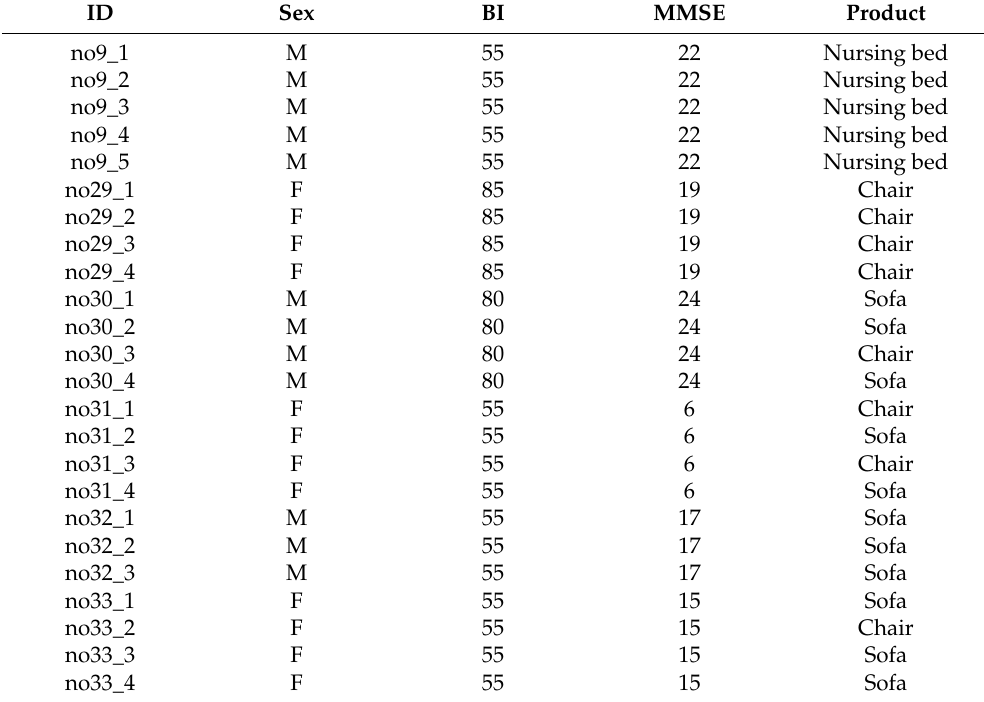
Table 1. Motion ID and life ability score and